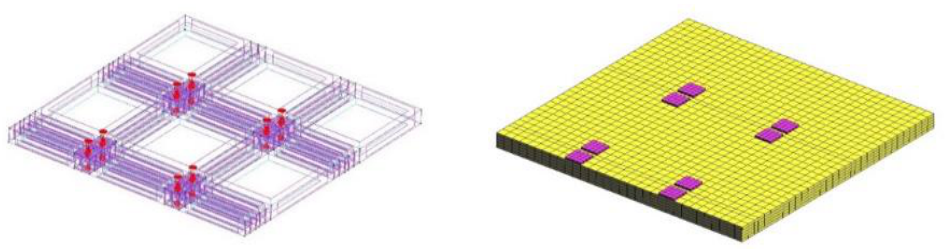
Figure 4. Rigid pavement boundary condition and meshing.